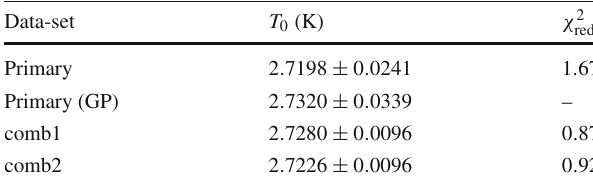
Table 1 Estimates of T 0 obtained for each data-set at 1 σ confidence level, along with the reduced χ 2 value, i.e., χ 2 divided by the number red of degrees of